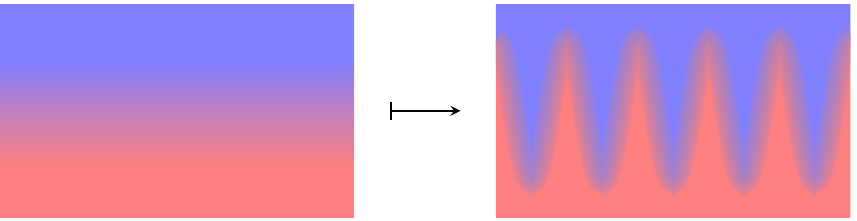
Figure 6 . The new path produced by the composition f paths from A to B g ! f invertible defects between A and B g ! f paths from A to B g from an old path from system A (red) to system B (blue). The horizontal direction denotes the spatial direction x used to de(cid:12)ne the map f paths from A to B g ! f invertible defects between A and B g , and the vertical direction denotes the \internal time" parameter along which the path from A to B transforms.